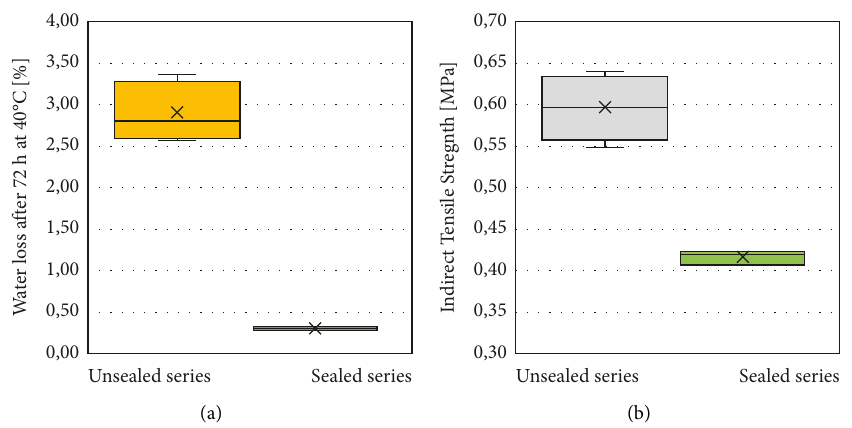
Figure 4: Results of quality control tests on the CRM mixture: (a) water loss; (b)